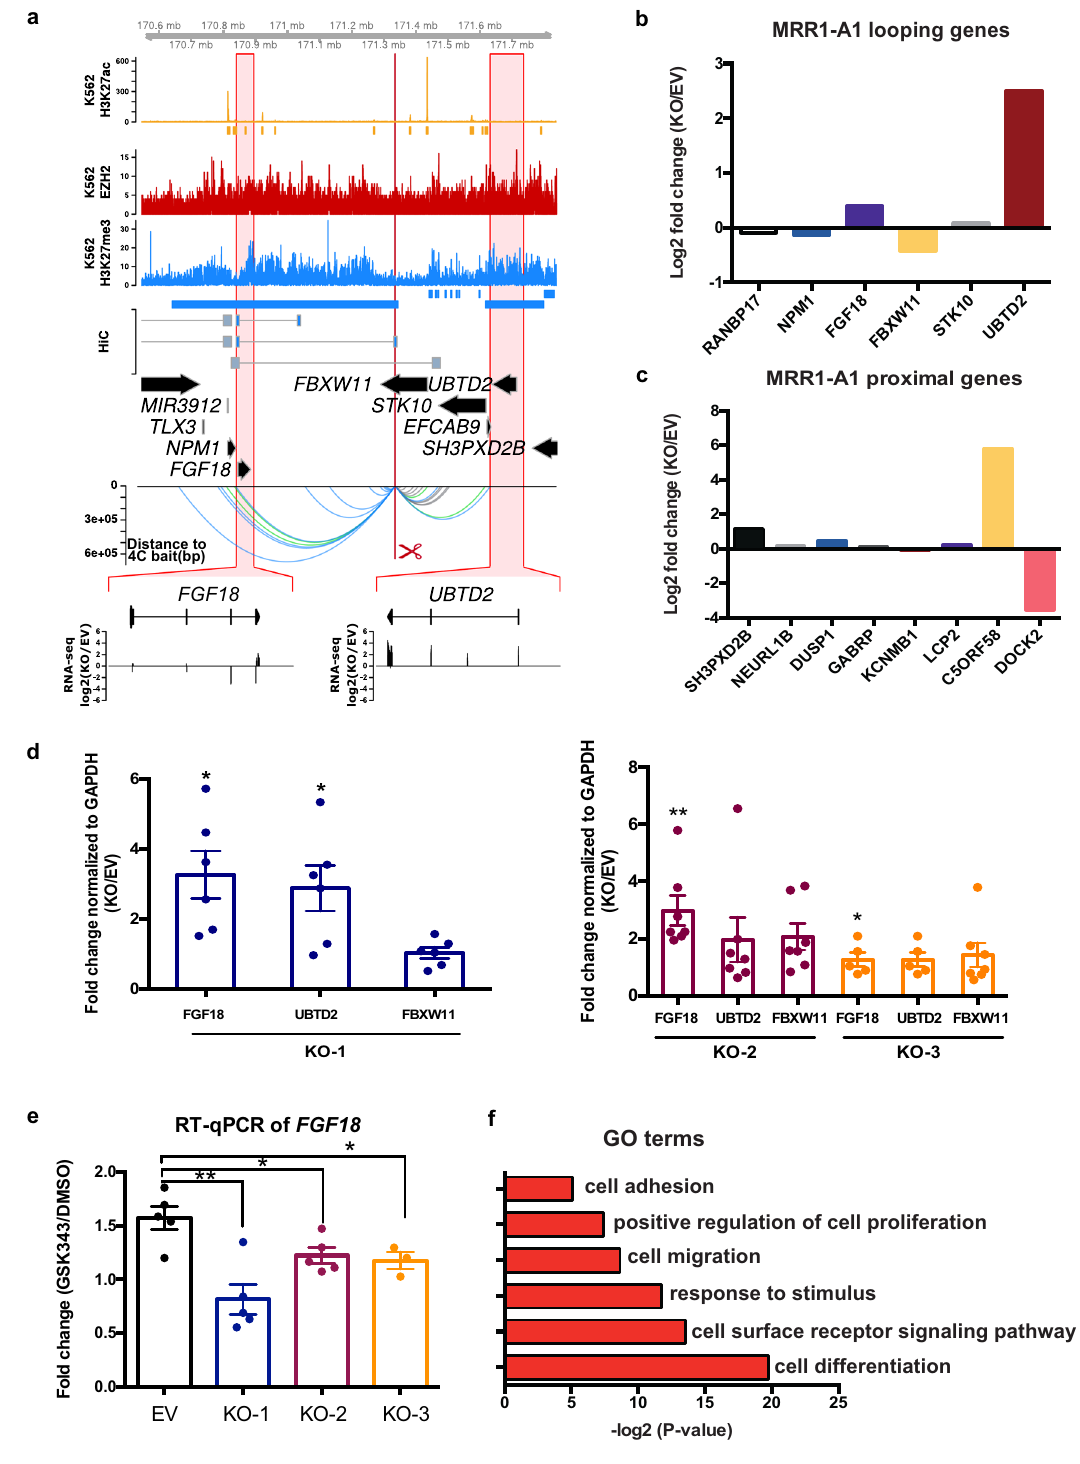
(Fig. 3a). From RNA-seq fold changes of MRR1-A1 looping genes, we found upregulation of FGF18 and UBTD2 (Fig. 3b, Supplementary Fig. 3d). For proximal genes, we found upregula- tion of genes including SH3PXD2B and C5ORF58 (Fig. 3c, Supplementary Fig. 3e). Among those genes, upregulation of the FGF18 was further con fi rmed by RT-qPCR consistently in three different KO clones (Fig. 3d) while UBTD2 was